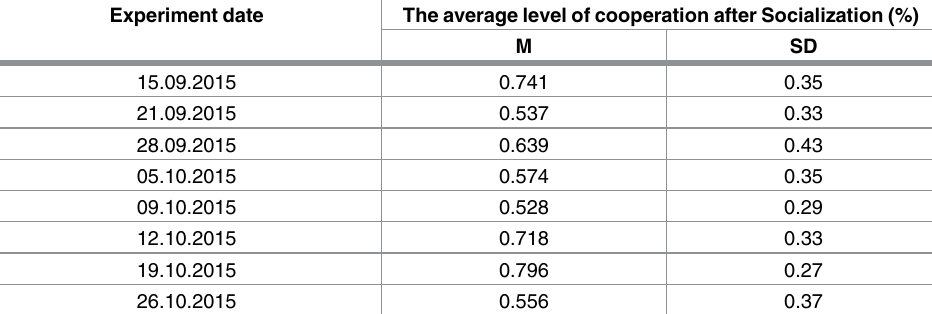
Table 3. The average levels of the cooperative moves in PD after Socialization.